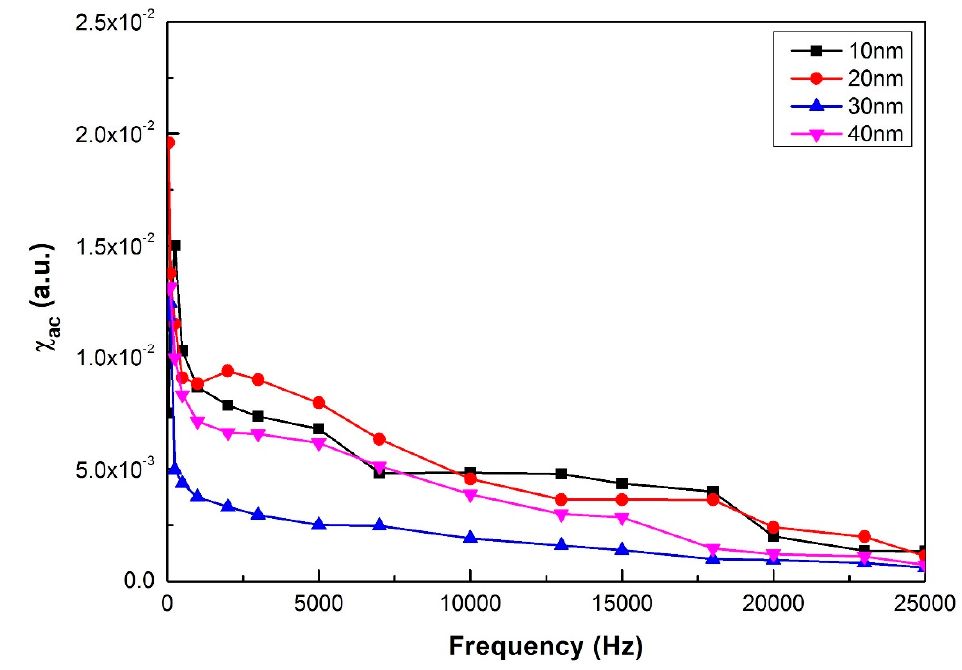
Figure 3. For samples with a thickness of 10 nm to 40 nm, the low-frequency alternate-current magnetic susceptibility ( χ ac ) as a function of the frequency from 10 to 25,000 Hz.